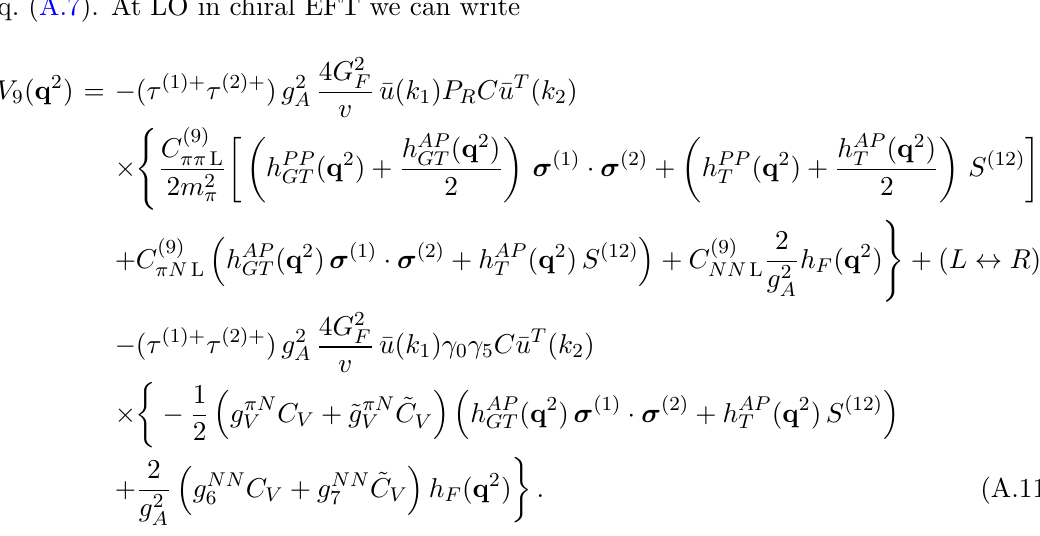
ppee scattering amplitude. ! (cid:0) (cid:1) ^ r (cid:27) ( n ) ^ r 3 (cid:27) ( m ) (cid:27) ( m ) (cid:27) ( n ) (cid:1) (cid:1) (cid:0) (cid:1)